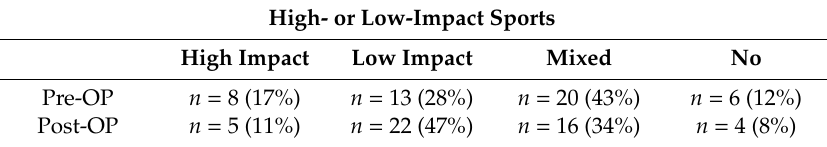
Table 5. High- or low-impact sports. Overview of patients performing high- or low-impact activities or a mix of both kinds of